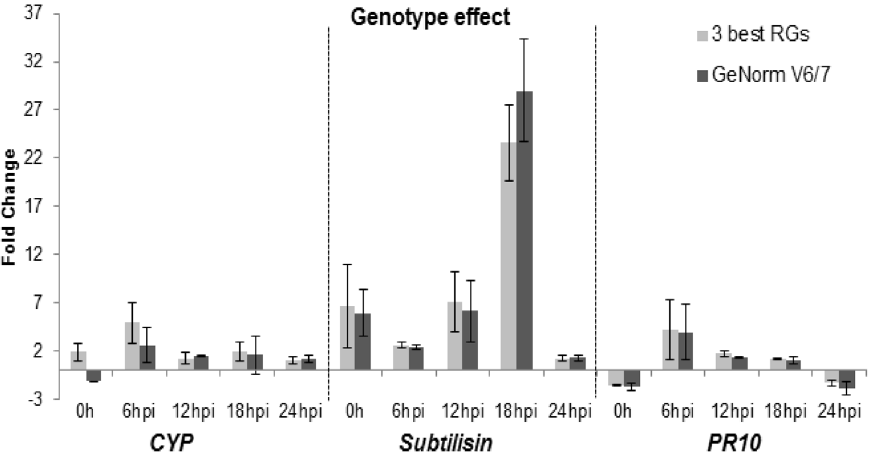
Figure 4. Fold change variation when comparing Regent and Tricadeira prior and during inoculation time-course for subtilisin , CYP and PR10 . Two normalization strategies are presented. Fold Change: expression of Regent samples divided by Trincadeira samples. Asterisks indicate significant differences between each normalization strategy. RG, reference gene. Median and MAD (mean absolute deviation) values of three biological replicates are